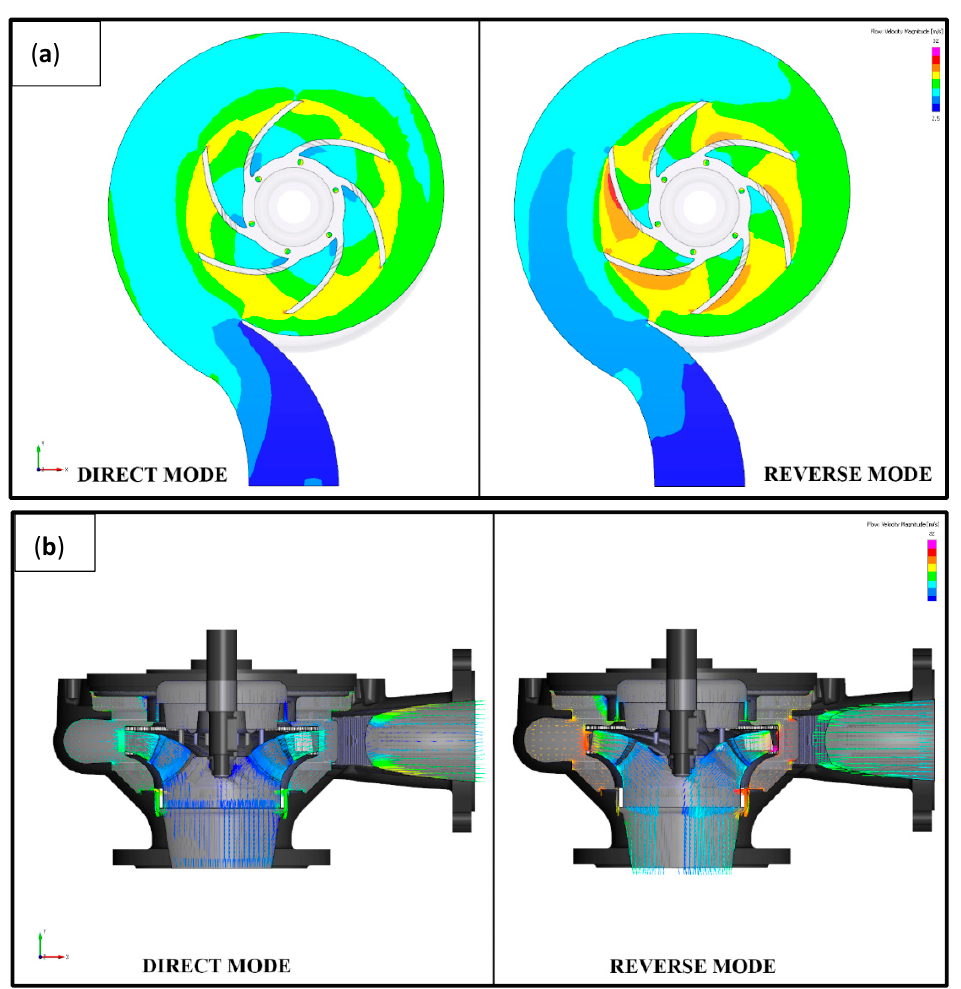
Figure 3. Model results for Pump 1 ( Ns = 37.6) at 2900 rpm. ( a ) Pressure distribution; ( b ) velocity vectors.